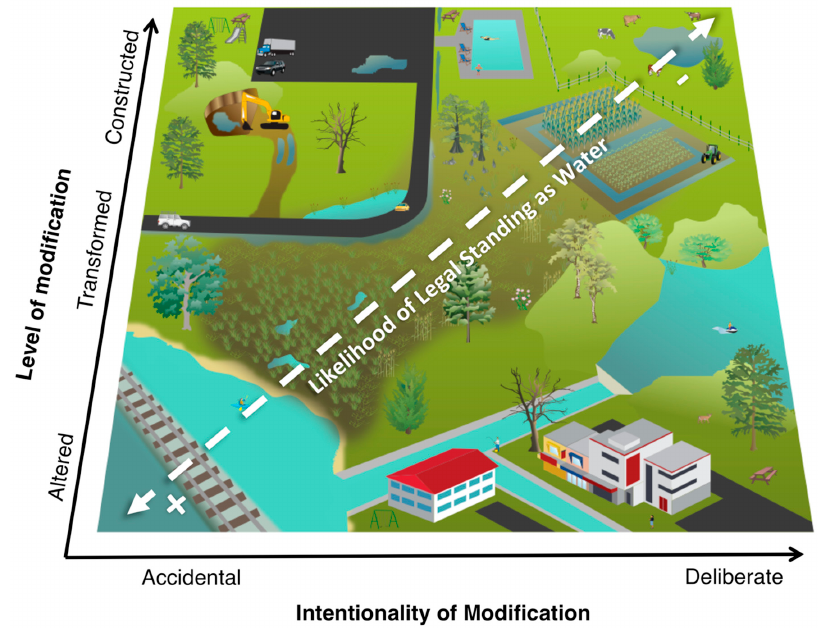
Figure 1. Classification of artificial aquatic systems. Level of deliberateness of modification increases from left to right, and degree of modification increases from bottom to top. These two axes combined yield a third axis, likelihood of legal standing as a water for regulatory purposes in the U.S., running from unlikely among deliberately constructed ecosystems like swimming pools and upland farm ponds in the upper right, to likely among accidentally altered ecosystems, like a lake bisected by a railroad causeway, in the lower left. Other potentially influential characteristics, such as size and permanence, may influence regulation in both natural and artificial systems.